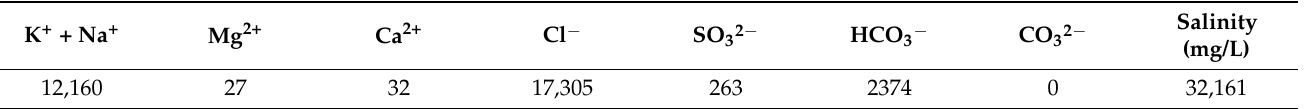
Table 1. Ionic composition of R reservoir formation water.